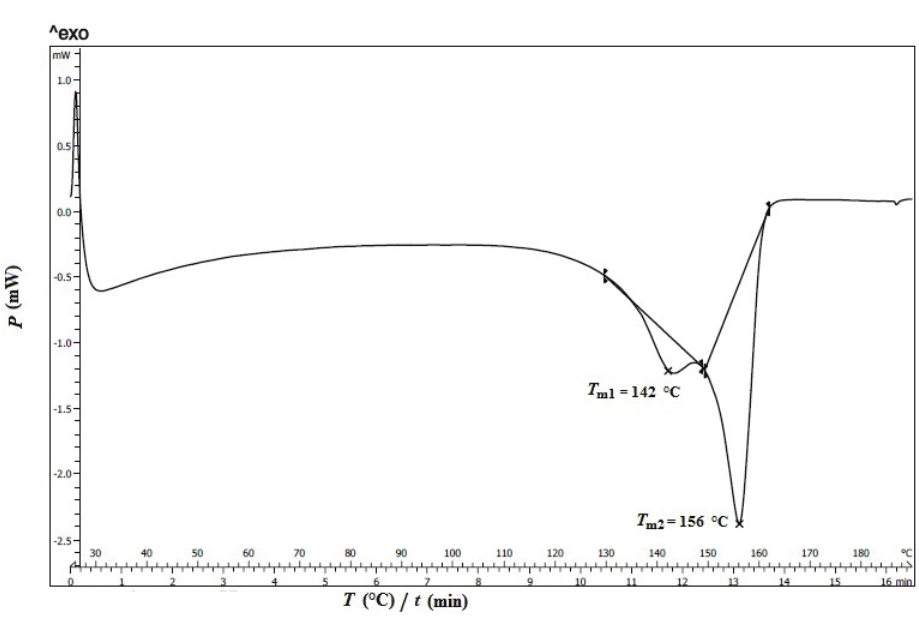
Fig. 5 – DSC thermogram of poly(3HB-co-24.6 %-3HV) copolymer obtained by C. necator DSM 545